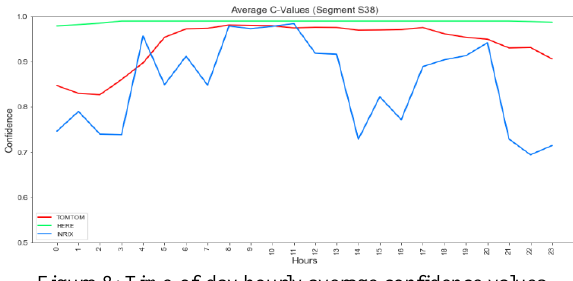
Figure 8: Time-of-day hourly average confidence values reported by the FCD services on Segment S38 during weekdays.